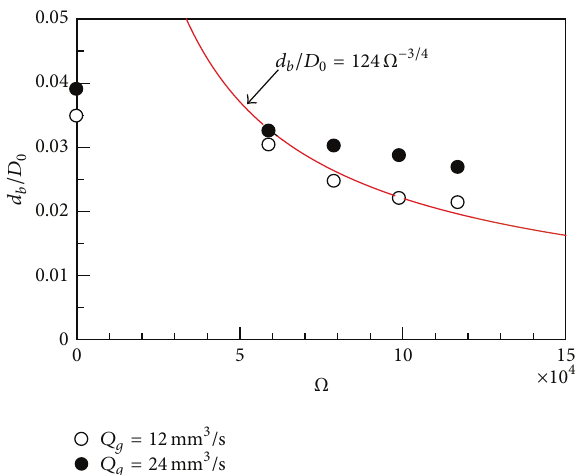
Figure 6: Relation between bubble diameter 𝑑 𝑏 and rotation num- ber Ω .